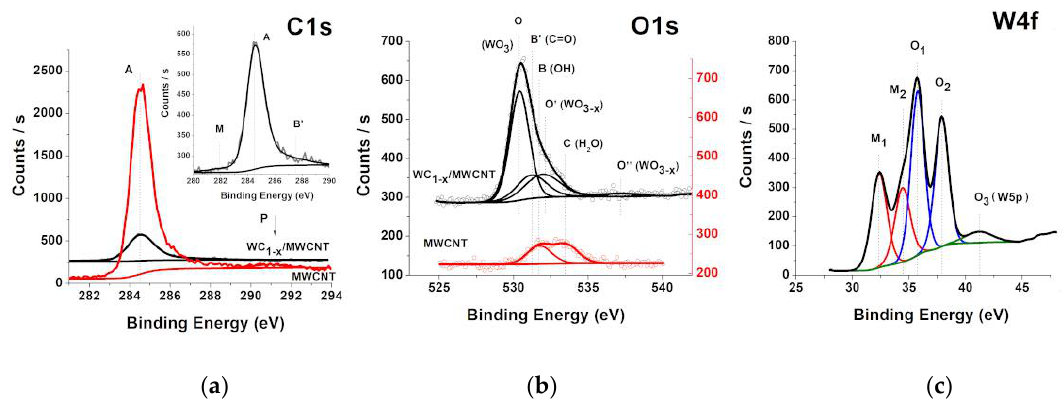
Figure 9. The C1 ( a ), O1 ( b ) XPS spectra of the WC 1-x / MWCNTs sample 2 (black) and initial MWCNTs (red). The inset in ( a ) shows the composite XPS C1 spectrum. ( c ) the W4f XPS spectra (black) fitting (colored) of the sample 2.